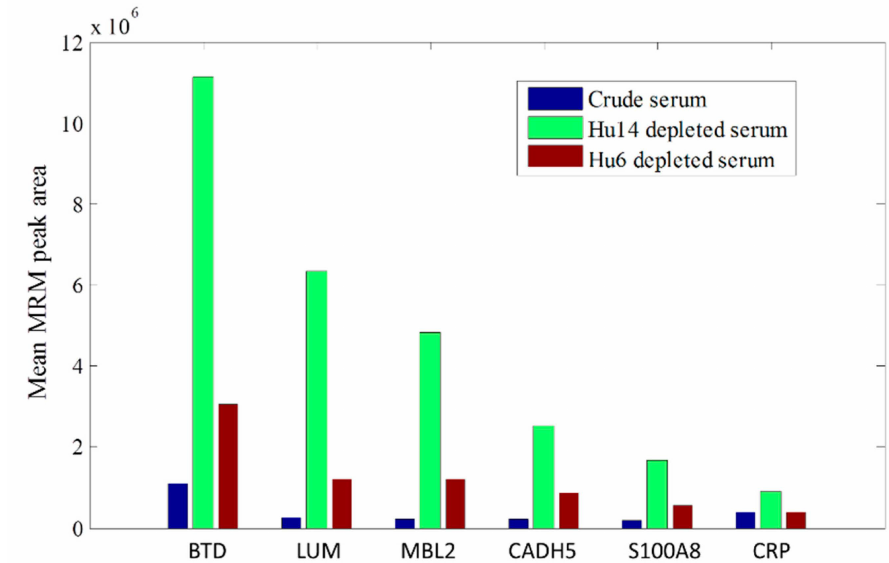
Figure 1. Immunodepletion performance assessment using MRM assays of selective serum proteins. Each value shown was based on the average of duplicative measurement. Largest MRM peak areas were observed with Hu14 depletion for all selective proteins. Please see Table 2 for